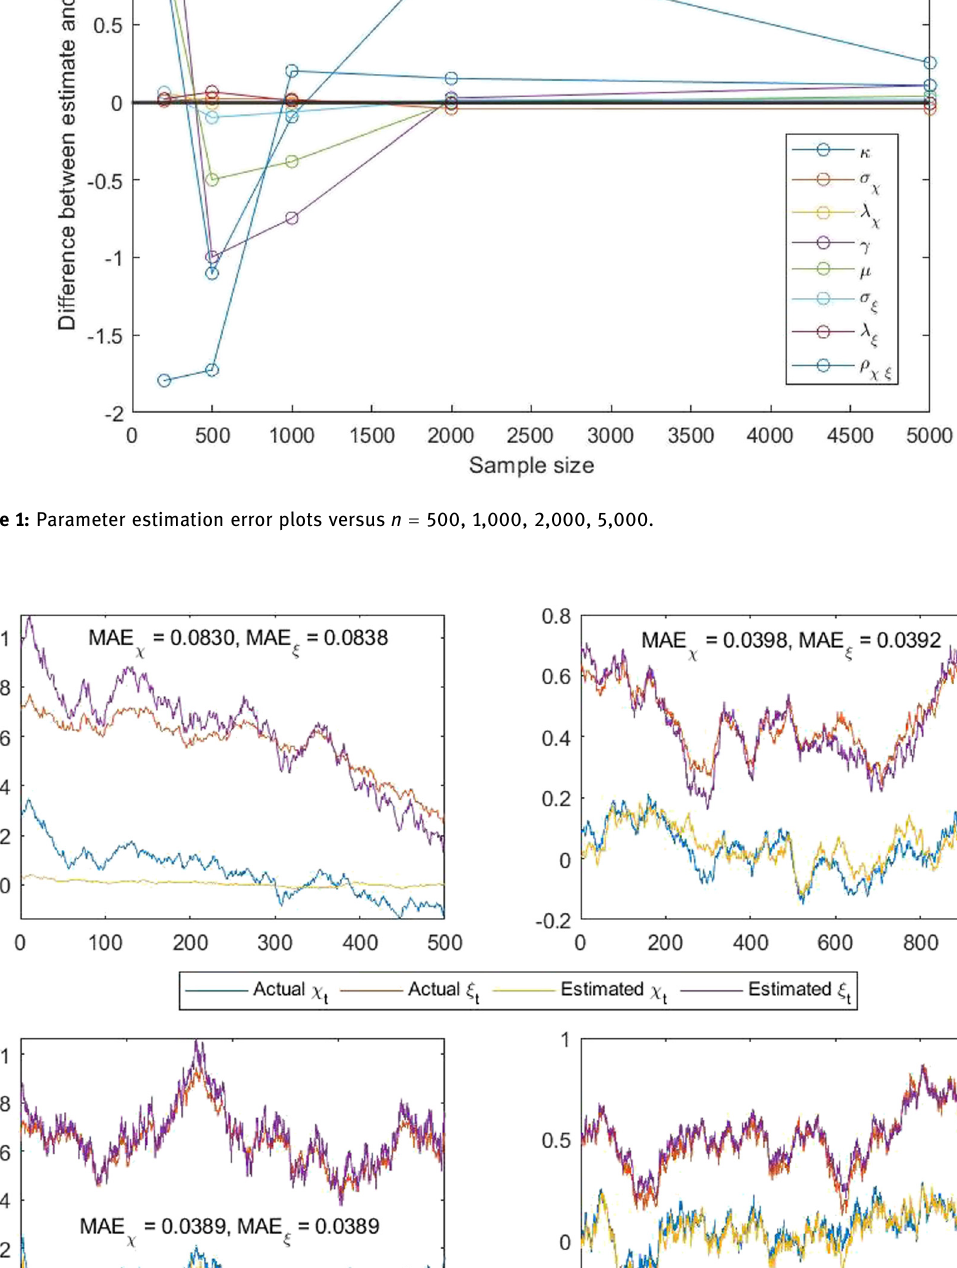
Figure 2: Actual and estimated χ right -